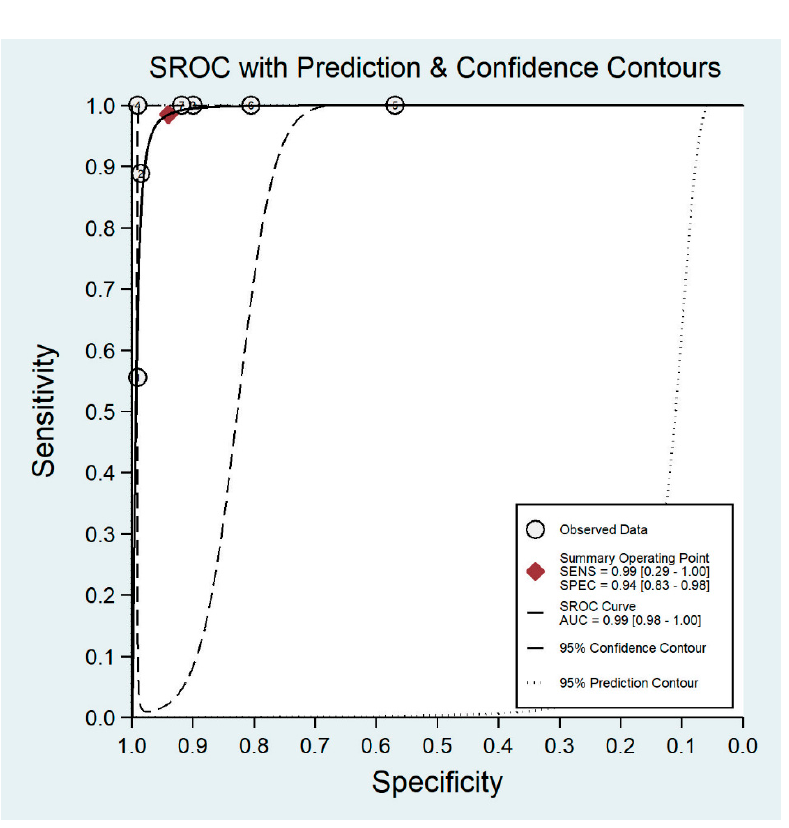
Figure 7. Receiver operating characteristic curve for non-mydriatic fundus imaging.